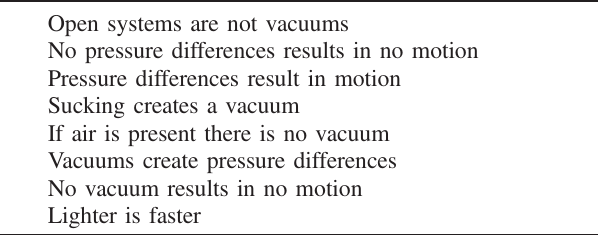
TABLE IX. Resources used in double straw